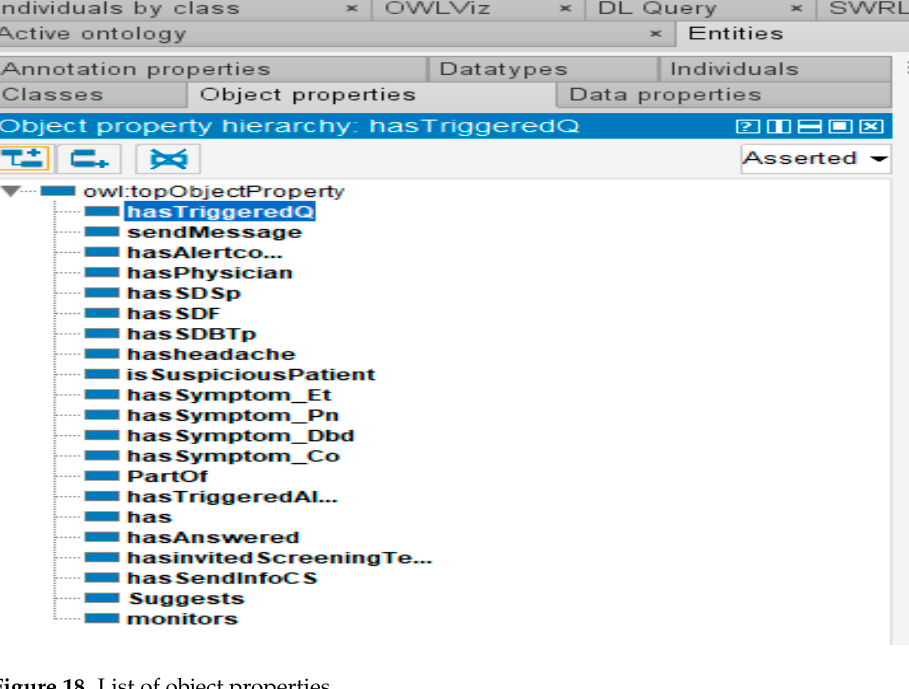
Figure 18. List of object properties.